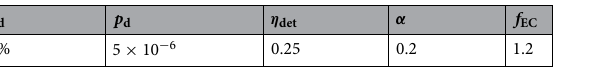
10 14 and various = 16 and consider various values for N . Moreover, we 10 − =